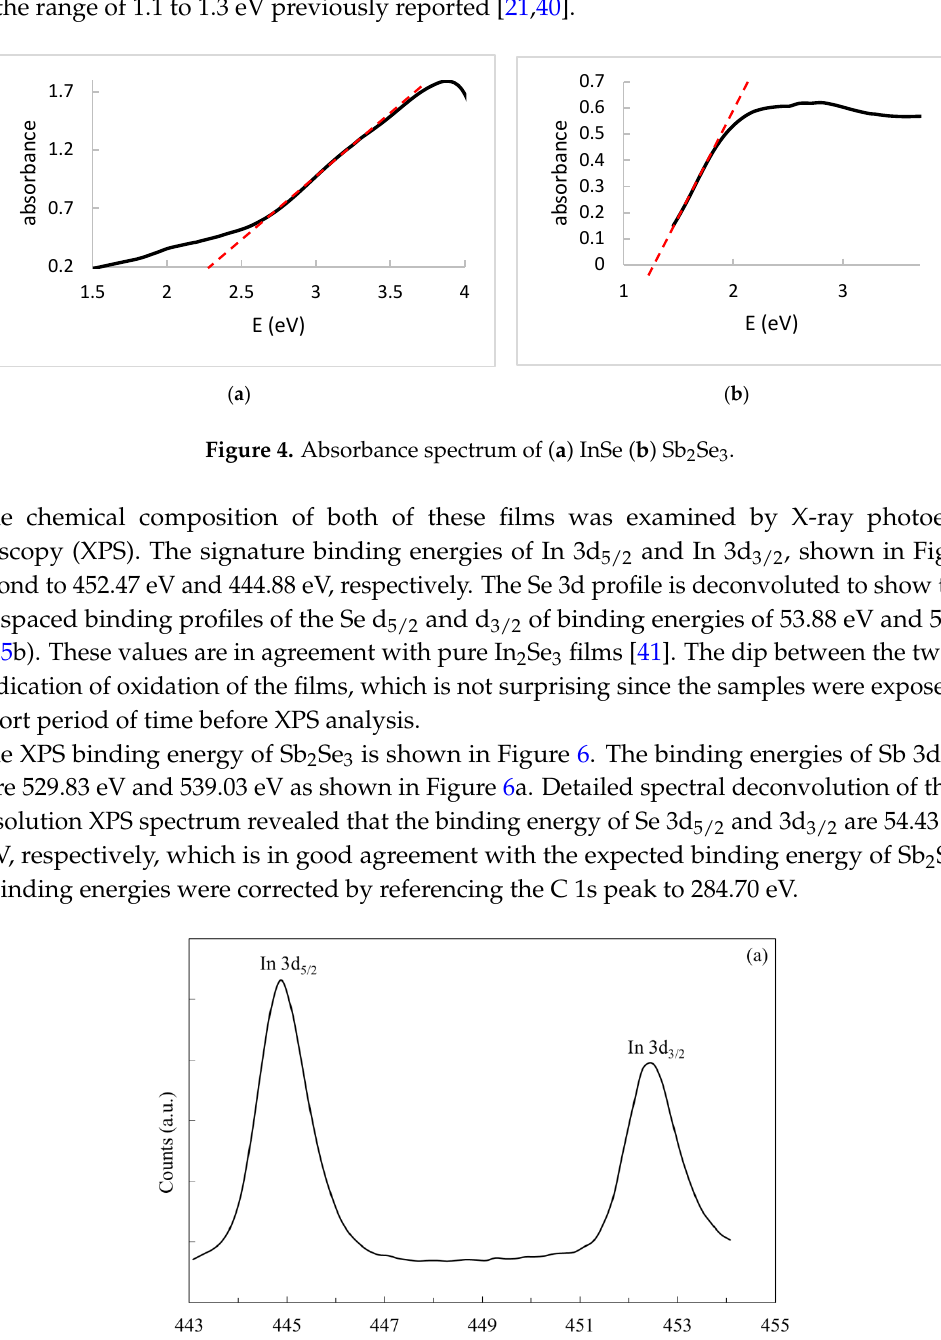
Figure 5. X-ray photoelectron spectroscopy (XPS) profile of ( a ) In ( b ) Se. The XPS binding energy of Sb 2 Se 3 is shown in Figure 6. The binding energies of Sb 3d 5/2 and 3d 3/2 are 529.83 eV and 539.03 eV as shown in Figure 6a. Detailed spectral deconvolution of the Se 3d high resolution XPS spectrum revealed that the binding energy of Se 3d 5/2 and 3d 3/2 are 54.43 eV and 55.23 eV, respectively, which is in good agreement with the expected binding energy of Sb 2 Se 3 [25]. These binding energies were corrected by referencing the C 1s peak to 284.70 eV.